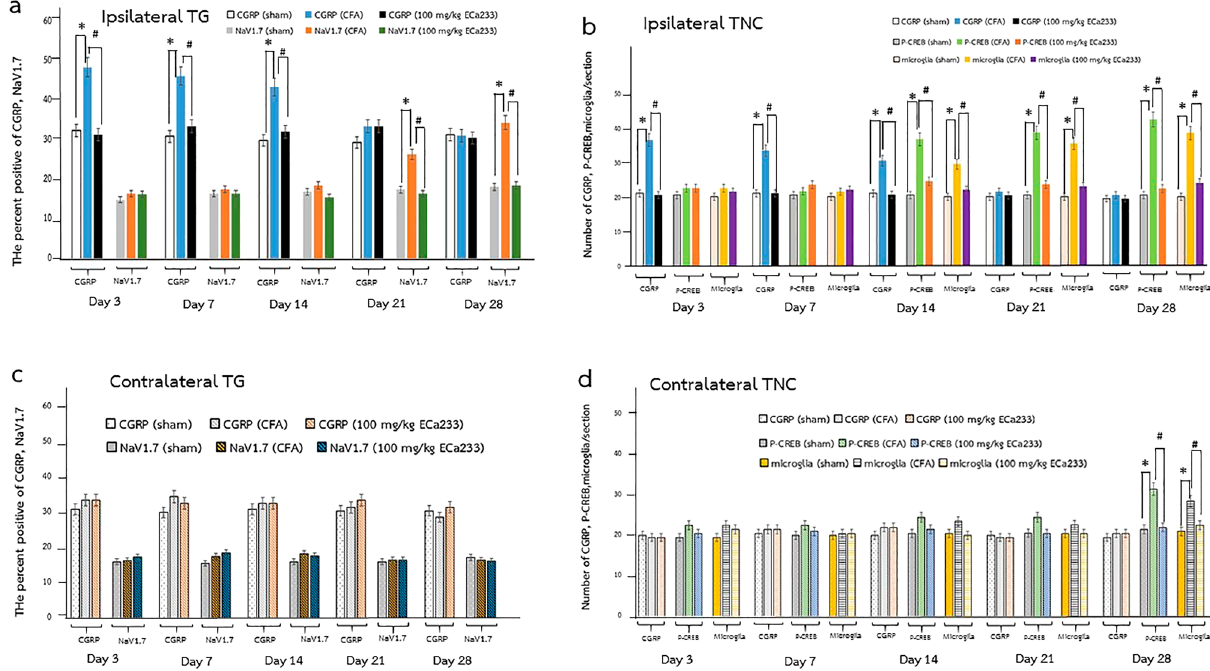
Figure 9. Expressions of CGRP and NaV1.7 in TG, and expressions of CGRP, p-CREB, and activated microglia in TNC in Sham, CFA, and 100ECa groups at different time points. ( a ) Expressions of CGRP and NaV1.7 in the ipsilateral TG. ( b ) Expressions of CGRP, p-CREB, and activated microglia in the ipsilateral TNC. ( c ) Expressions of CGRP and NaV1.7 in the contralateral TG. ( d ) Expressions of CGRP, p-CREB, and activated microglia in the contralateral TNC. (mean ± SEM; n = 3/group/time point; *P < 0.05 compared with the Sham group, # P < 0.05 compared with the CFA group, two-way analysis of variance followed by Fisher’s least significant difference post hoc